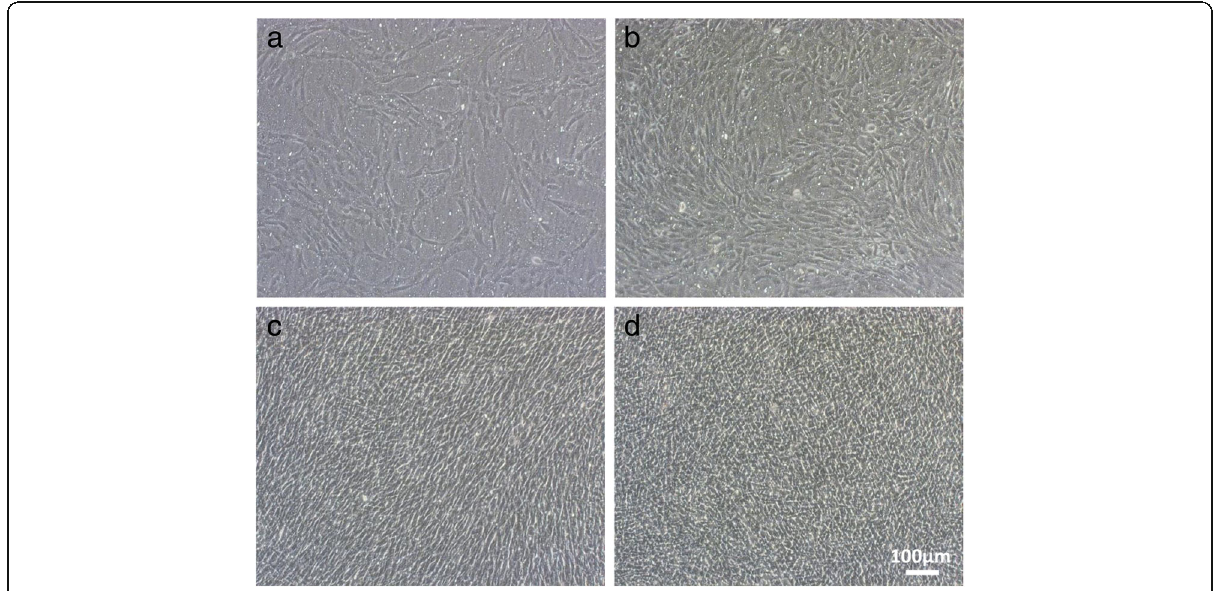
Fig. 2 Microscopic view of the proliferation of PDs. PDs seeded on temperature-responsive culture inserts were observed on day 3 ( a ), day 5 ( b ), day 7 ( c ), and day 14 ( d ) (×100). Cells reached confluence at day 5 and, by day 14, they were tightly packed. (Scale bar = 100 μ m)